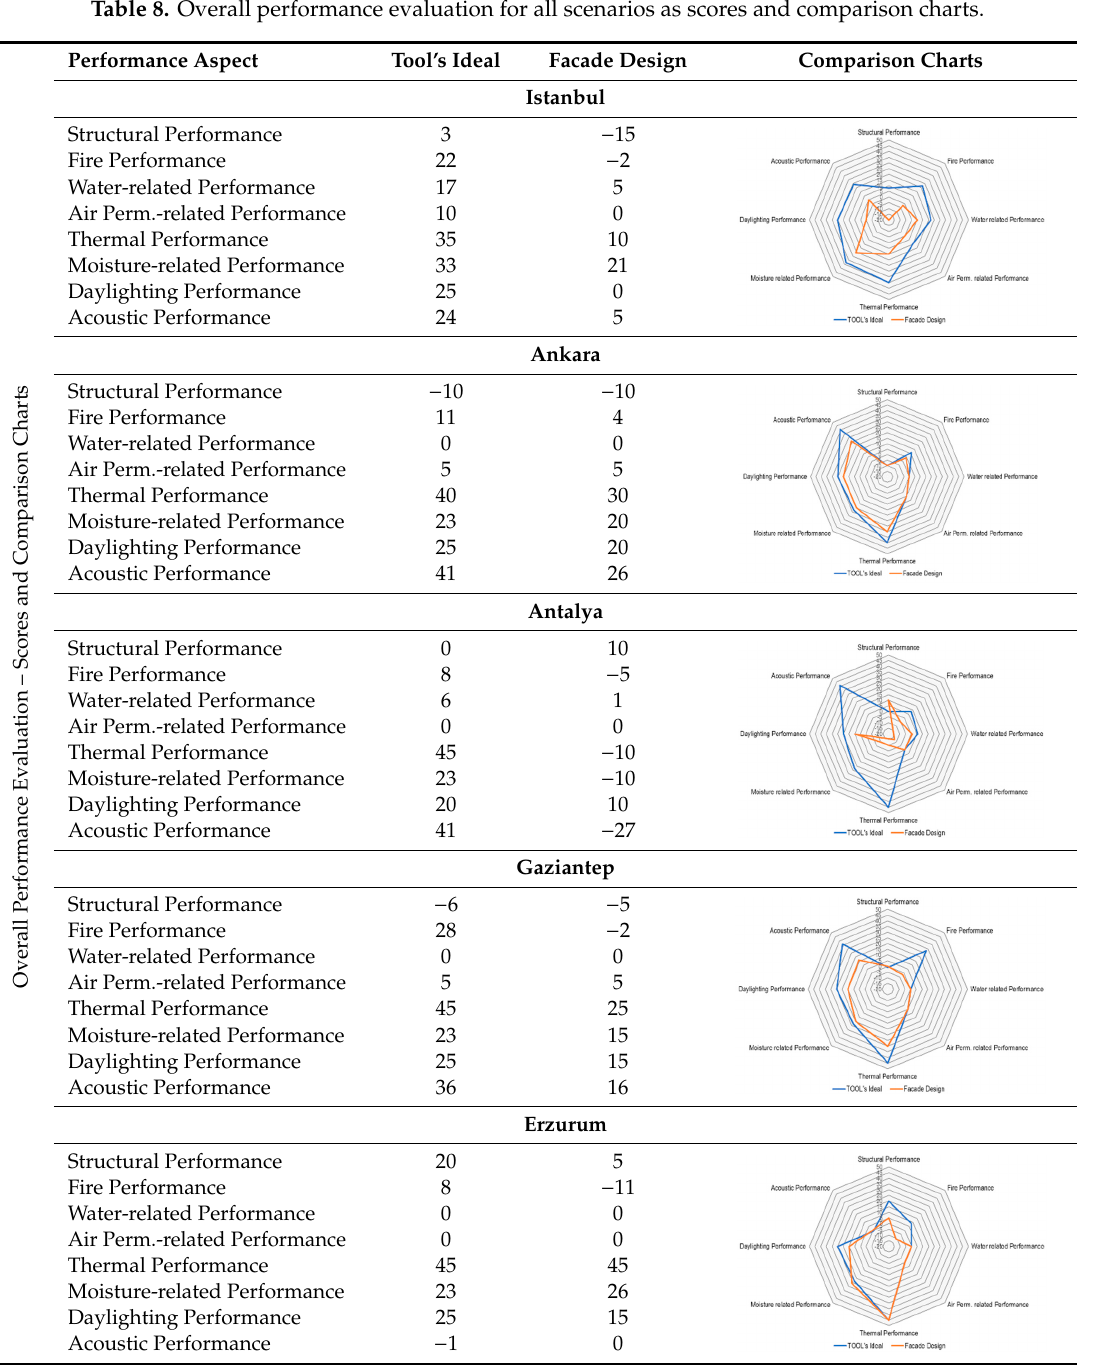
Figure 7. Design decisions and respective scores (screenshot from the tool). 5. Validation To evaluate the practicability of the tool and to come to a better conclusion, we conducted a series of interviews with the stakeholders of seven different projects from the same institution (educational) after allowing them to use the tool or see the tool’s outcomes. A classroom facade from each project was tested by the tool. The evaluation results are presented in Table